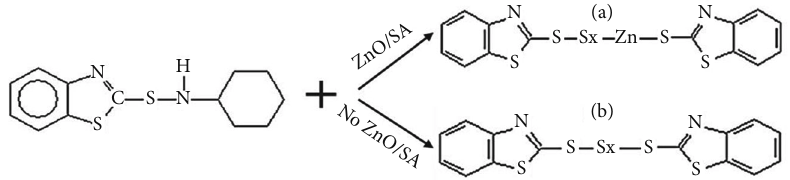
Figure 3: Typical reaction mechanism of non-activated cure systems. (a) Curing reactions of compounds containing activator systems and (b) curing reactions of compound without activator